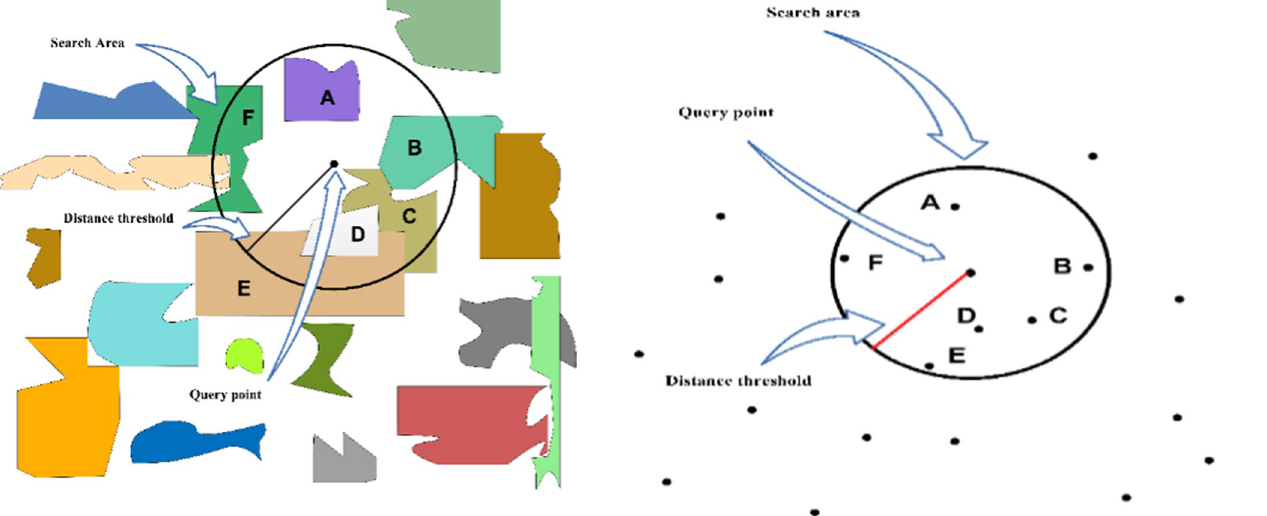
Fig. 4 Rang query operation over the approximated point